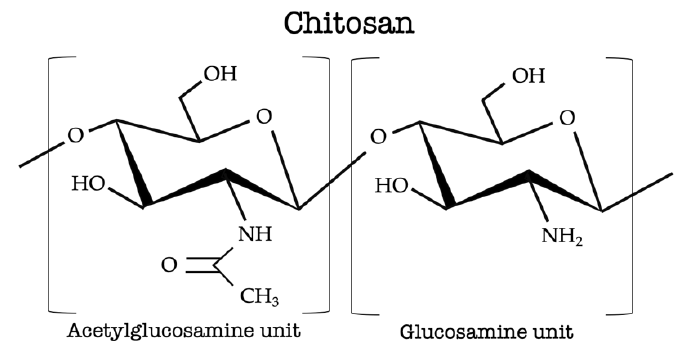
Figure 1. Chemical structure of chitosan.